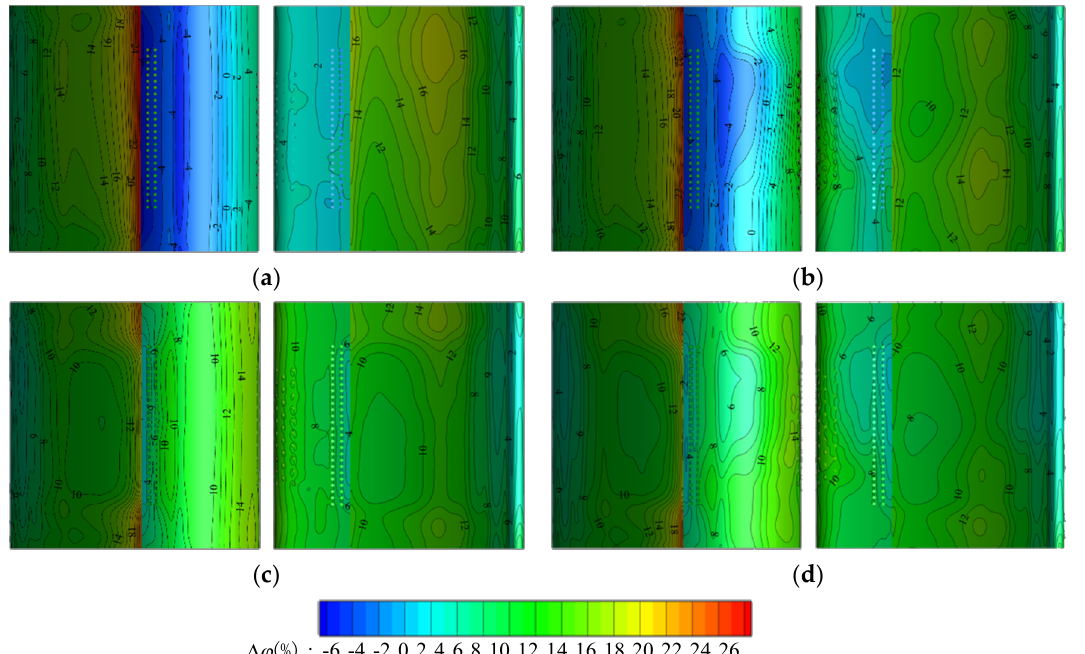
Figure 13. Overall cooling effectiveness comparisons increment for different cases. ( a ) uncoated vane without film, ( b ) uncoated vane with LE film, ( c ) uncoated vane with downstream film, ( d ) uncoated vane with LE and downstream film.